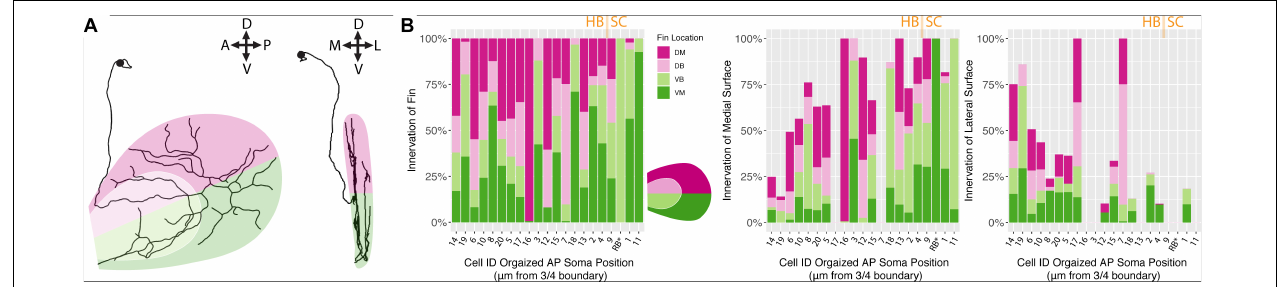
FIGURE 5 | Fin sensory neurons exhibit biases to specific fin areas depending on soma location. (A) A single neuron reconstruction shows coverage of all four quadrants (left panel), and also shows bias toward the medial surface of the fin (right panel). Note: due to the nature of the projection in the right panel, the overlay of the dorsal and ventral shadings is consistent with the shading at the level of the blood vessel. (B) The distribution of primary processes across the fin quadrants including the dorsal membrane (DM, dark pink), dorsal base (DB, light pink), ventral base (VB, light green), and ventral membrane (VM, dark green) (left panel). Notably, the highest percentage of the total length of fibers is found in the medial fin surface (middle panel) across all quadrants compared to the lateral fin (right panel). Soma position values corresponding to the Cell IDs are detailed in Supplementary Table S3 .